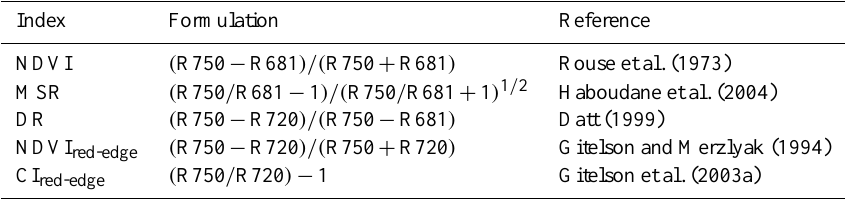
Table 2. Spectral vegetation indices presented in this study: normalized difference vegetation index (NDVI), modified simple ratio (MSR), difference ratio (DR), red-edge normalized difference vegetation index (NDVI red-edge ), and chlorophyll index (CI red-edge ). R refers to re- flectance at a specific band (nm).